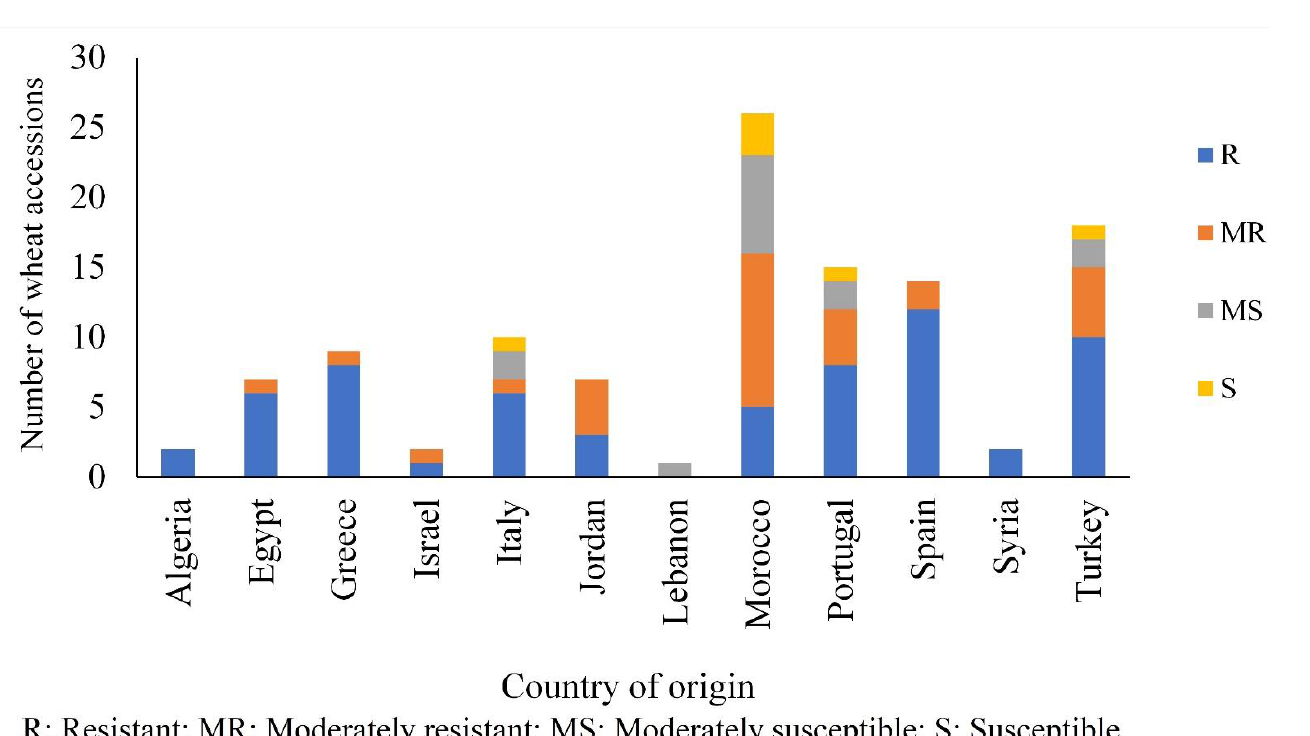
Figure 4. Frequencies of resistance levels (%) of 113 durum wheat accession’s reactions to tan spot disease in-field at the seedling stage among countries of origin in the 2018–2019 cropping season.